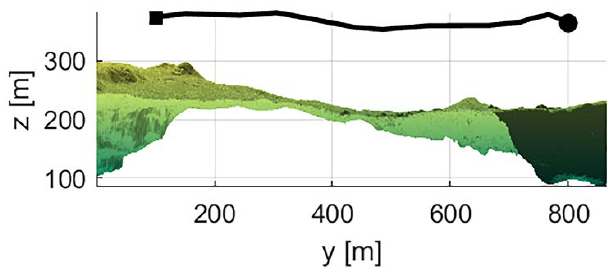
Figure 11. Convergence graph of the fitness function of the three algorithms.